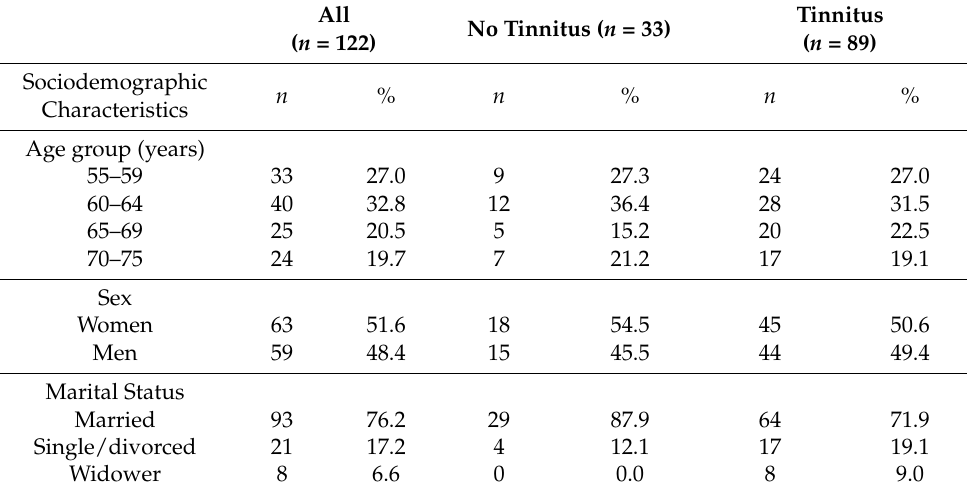
Table 1. Sociodemographic characteristics.